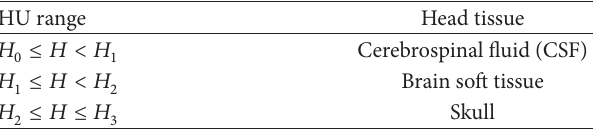
Table 1: HU range for different head